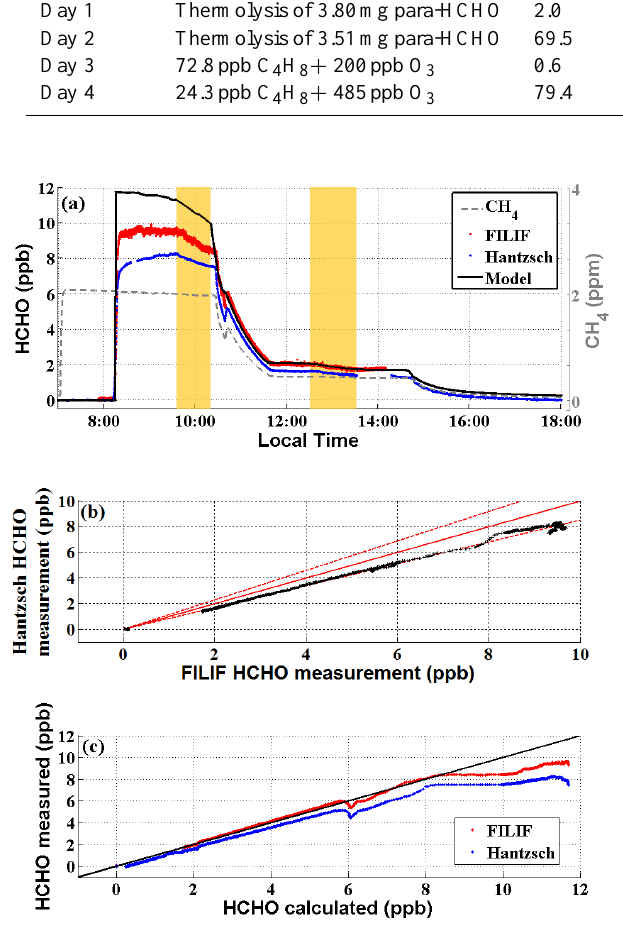
Figure 1. (a) Time series of measured and calculated HCHO mix- ing ratios as well as the dilution tracer (CH 4 ) during day 1, with periods of illumination denoted by yellow panels. (b) Comparison between HCHO measurements. Error bars represent 3 σ precision. Lines represent 1 : 1 agreement and ± 15% FILIF measurements. (c) Measurement/model comparison, with the line showing 1 : 1 agreement.